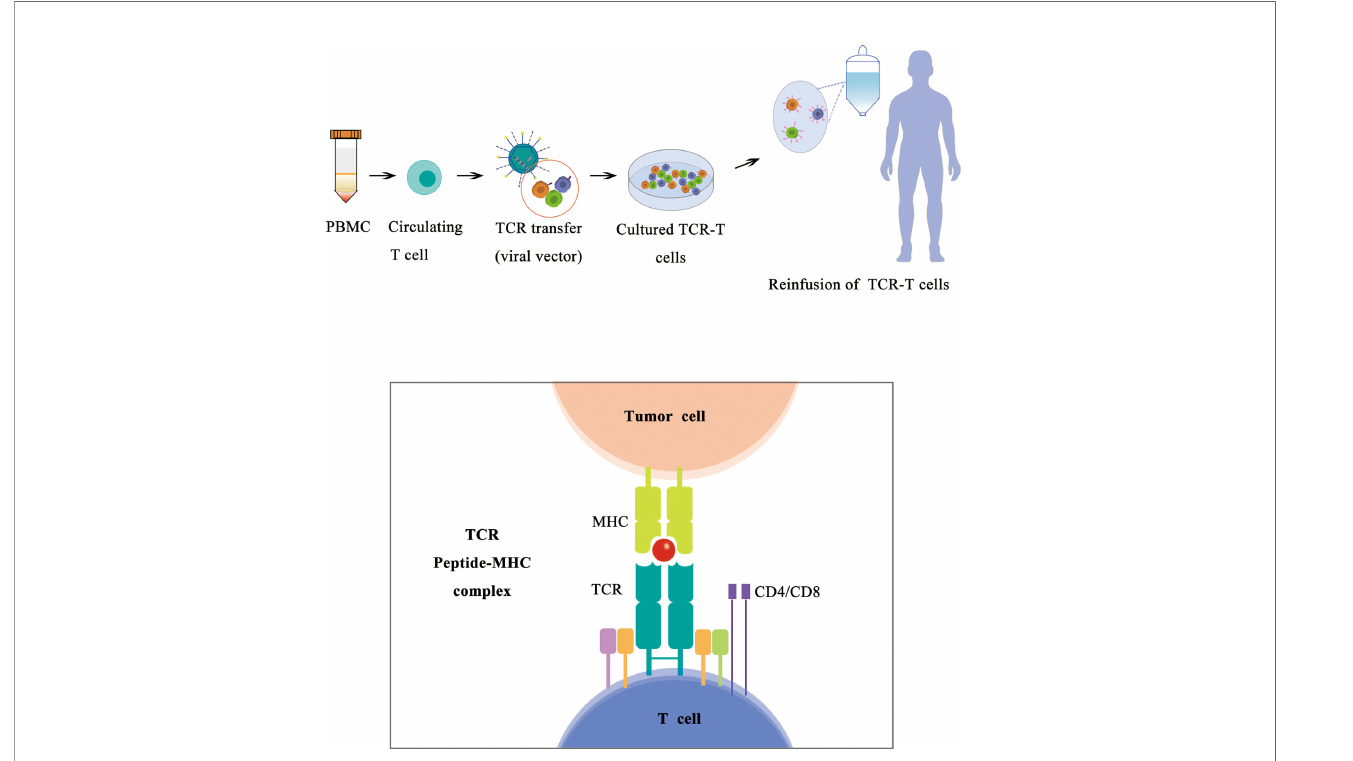
FIGURE 5 | Schematic diagram of TCR-T